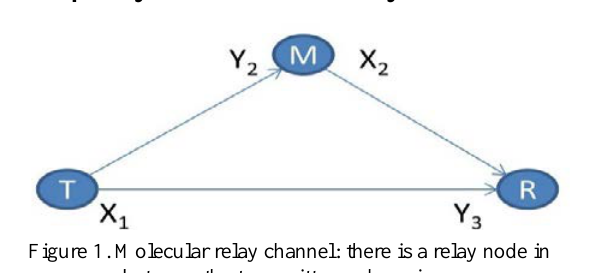
Figure 1. Molecular relay channel: there is a relay node in between the transmitter and